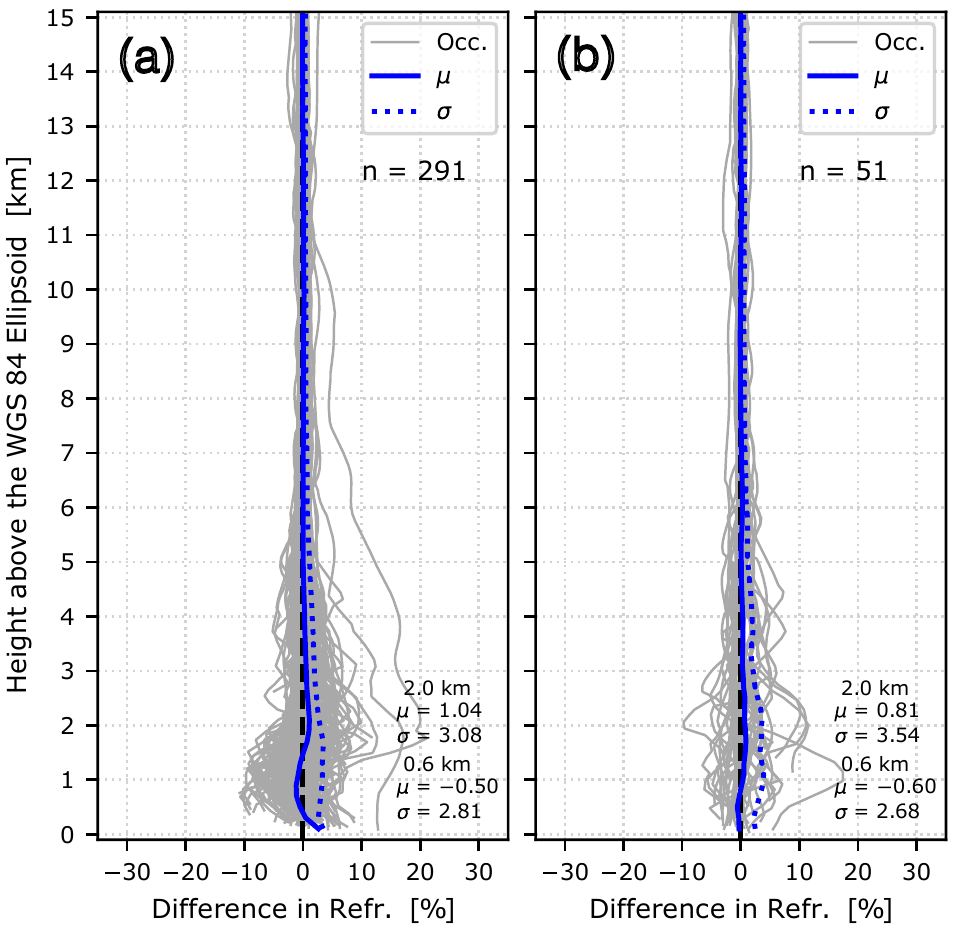
Figure 16. Statistical comparison between the Spire dataset occultations (blue lines) during AR Recon that sampled ( a ) outside and ( b ) inside an atmospheric river and the ERA5 reanalysis product. Notation the same as Figure